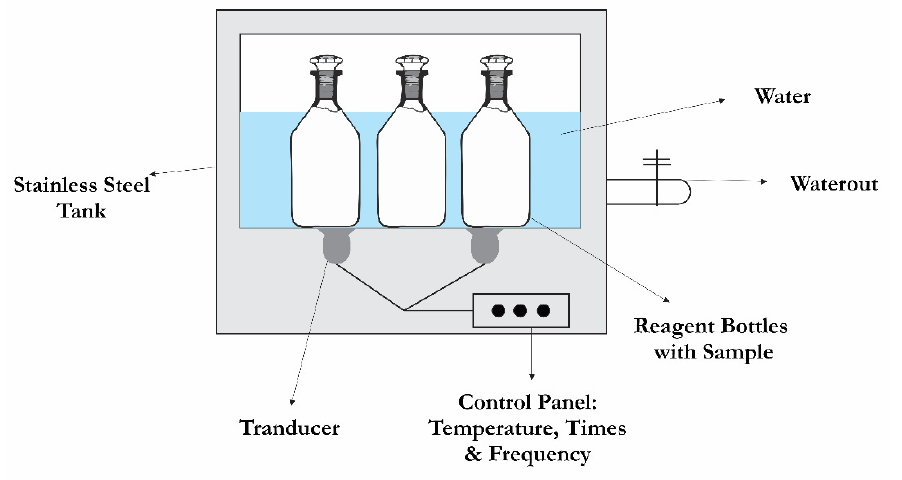
Figure 2. Ultrasonic bath mode.